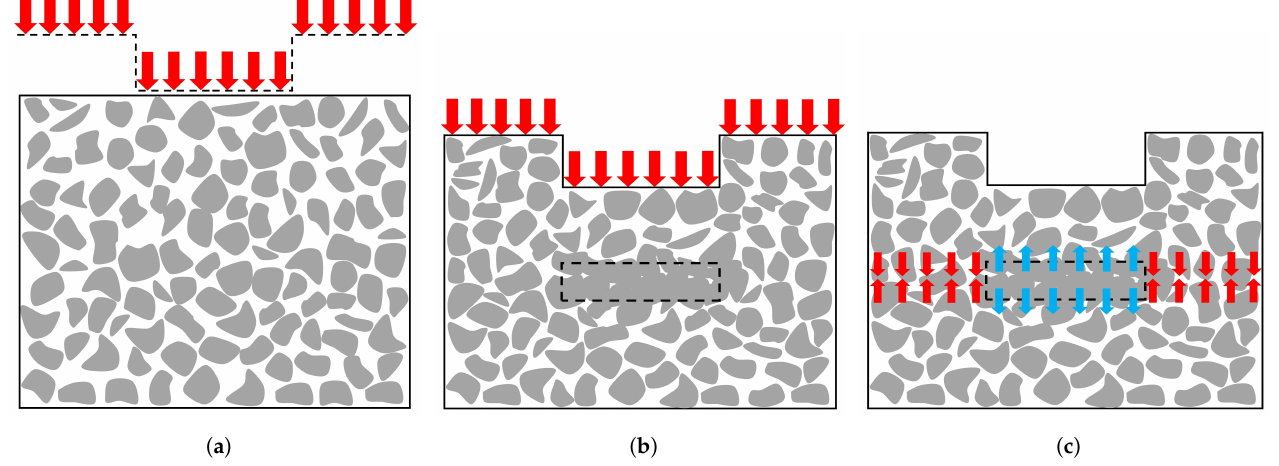
Figure 2. Generation of the residual tensile stresses due to compaction band formation. ( a ) The carbon anode paste before the compaction process. ( b ) The carbon anode paste during the compaction process and the formation of the compaction band (dashed rectangle). ( c ) Creating residual stresses in the absence of the external pressure. (The red arrows indicate the compression stresses and the blue ones show the tensile